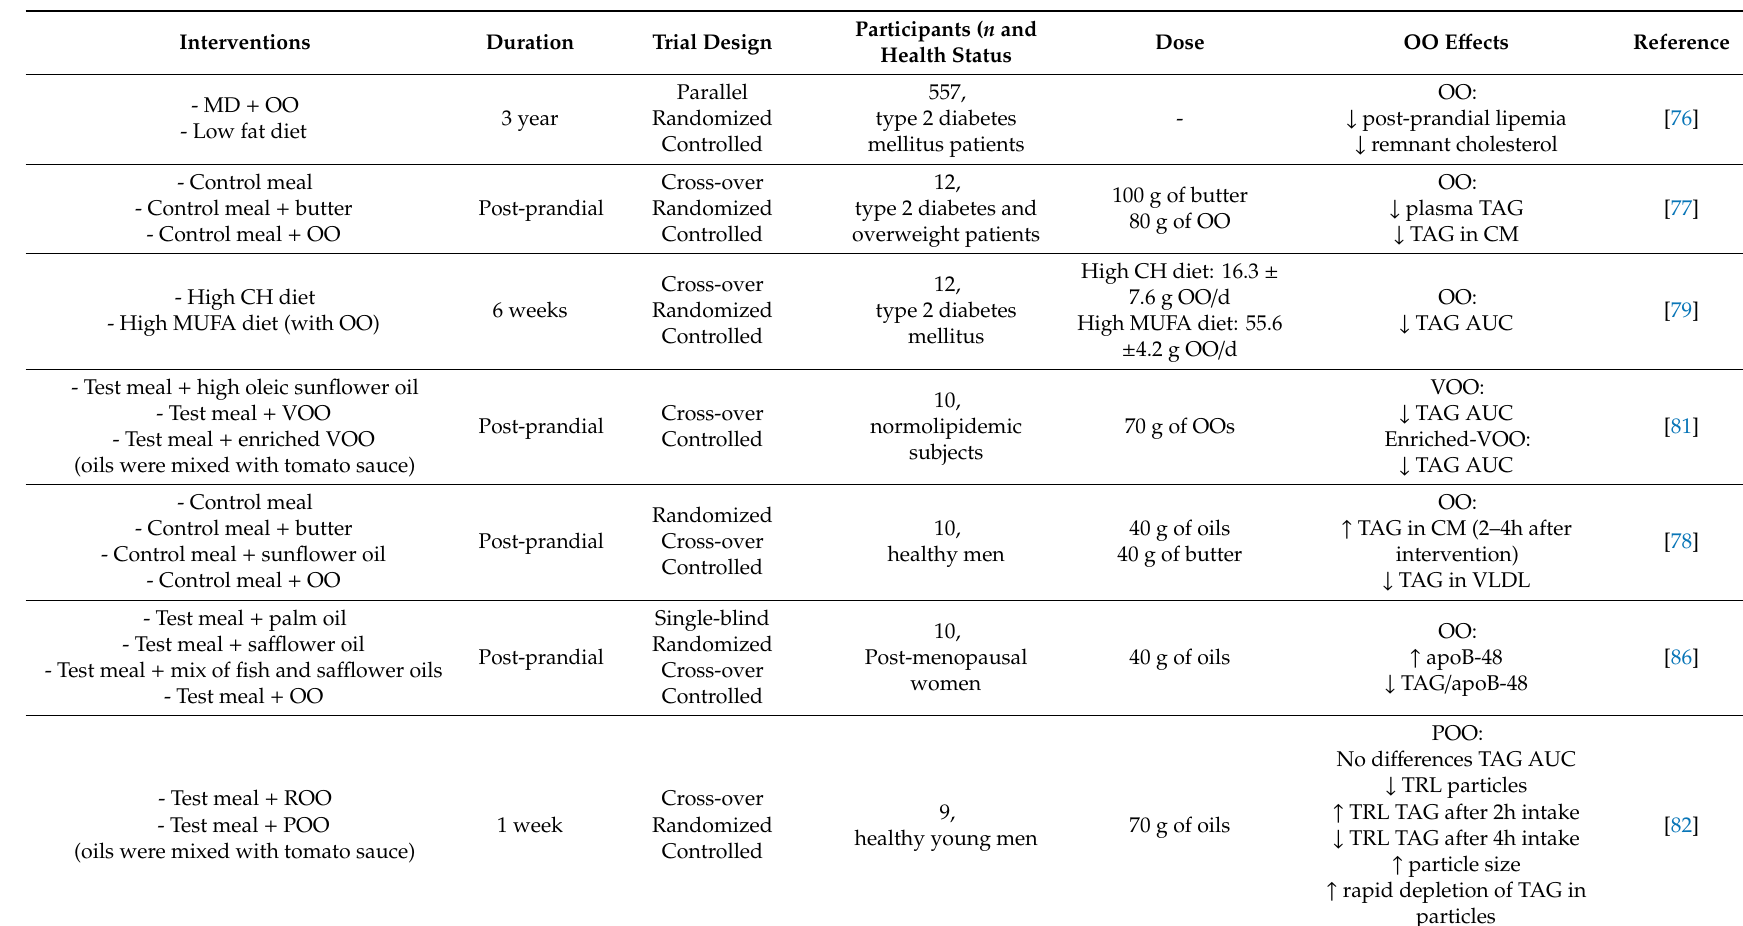
Table 3. Clinical trials which analysed the e ff ects of OO, VOO and phenol-enriched VOO on post-prandial